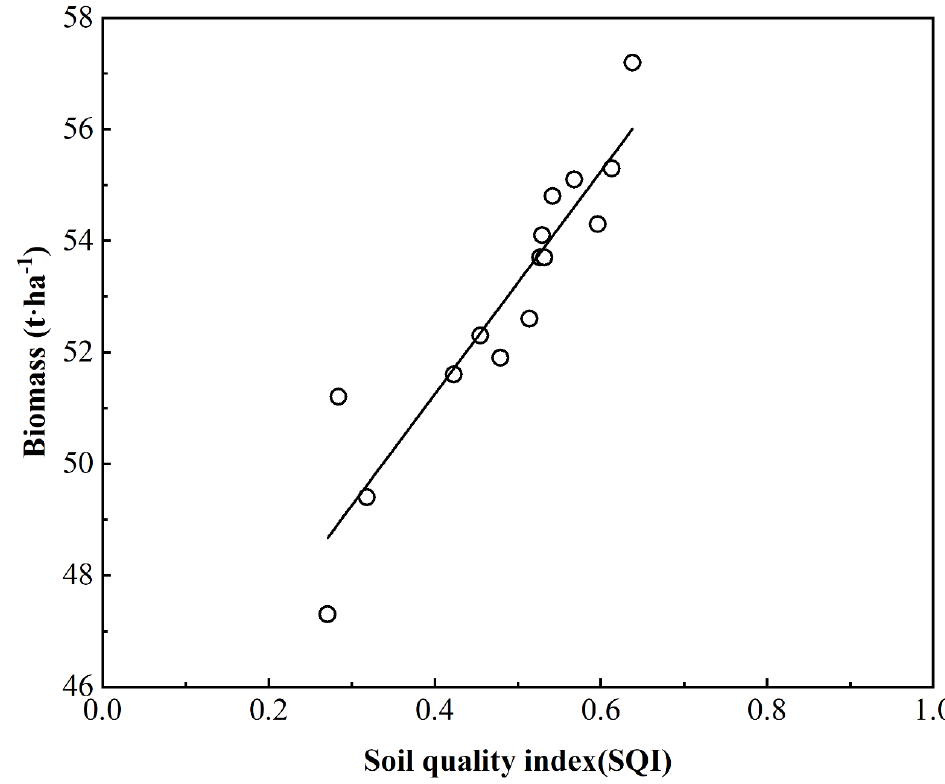
Figure 4. Correlation between soil quality index and biomass of Melaleuca alternifolia .